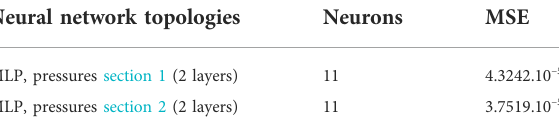
TABLE 1 Results achieved by each neural network model on the test samples. Neural network topologies